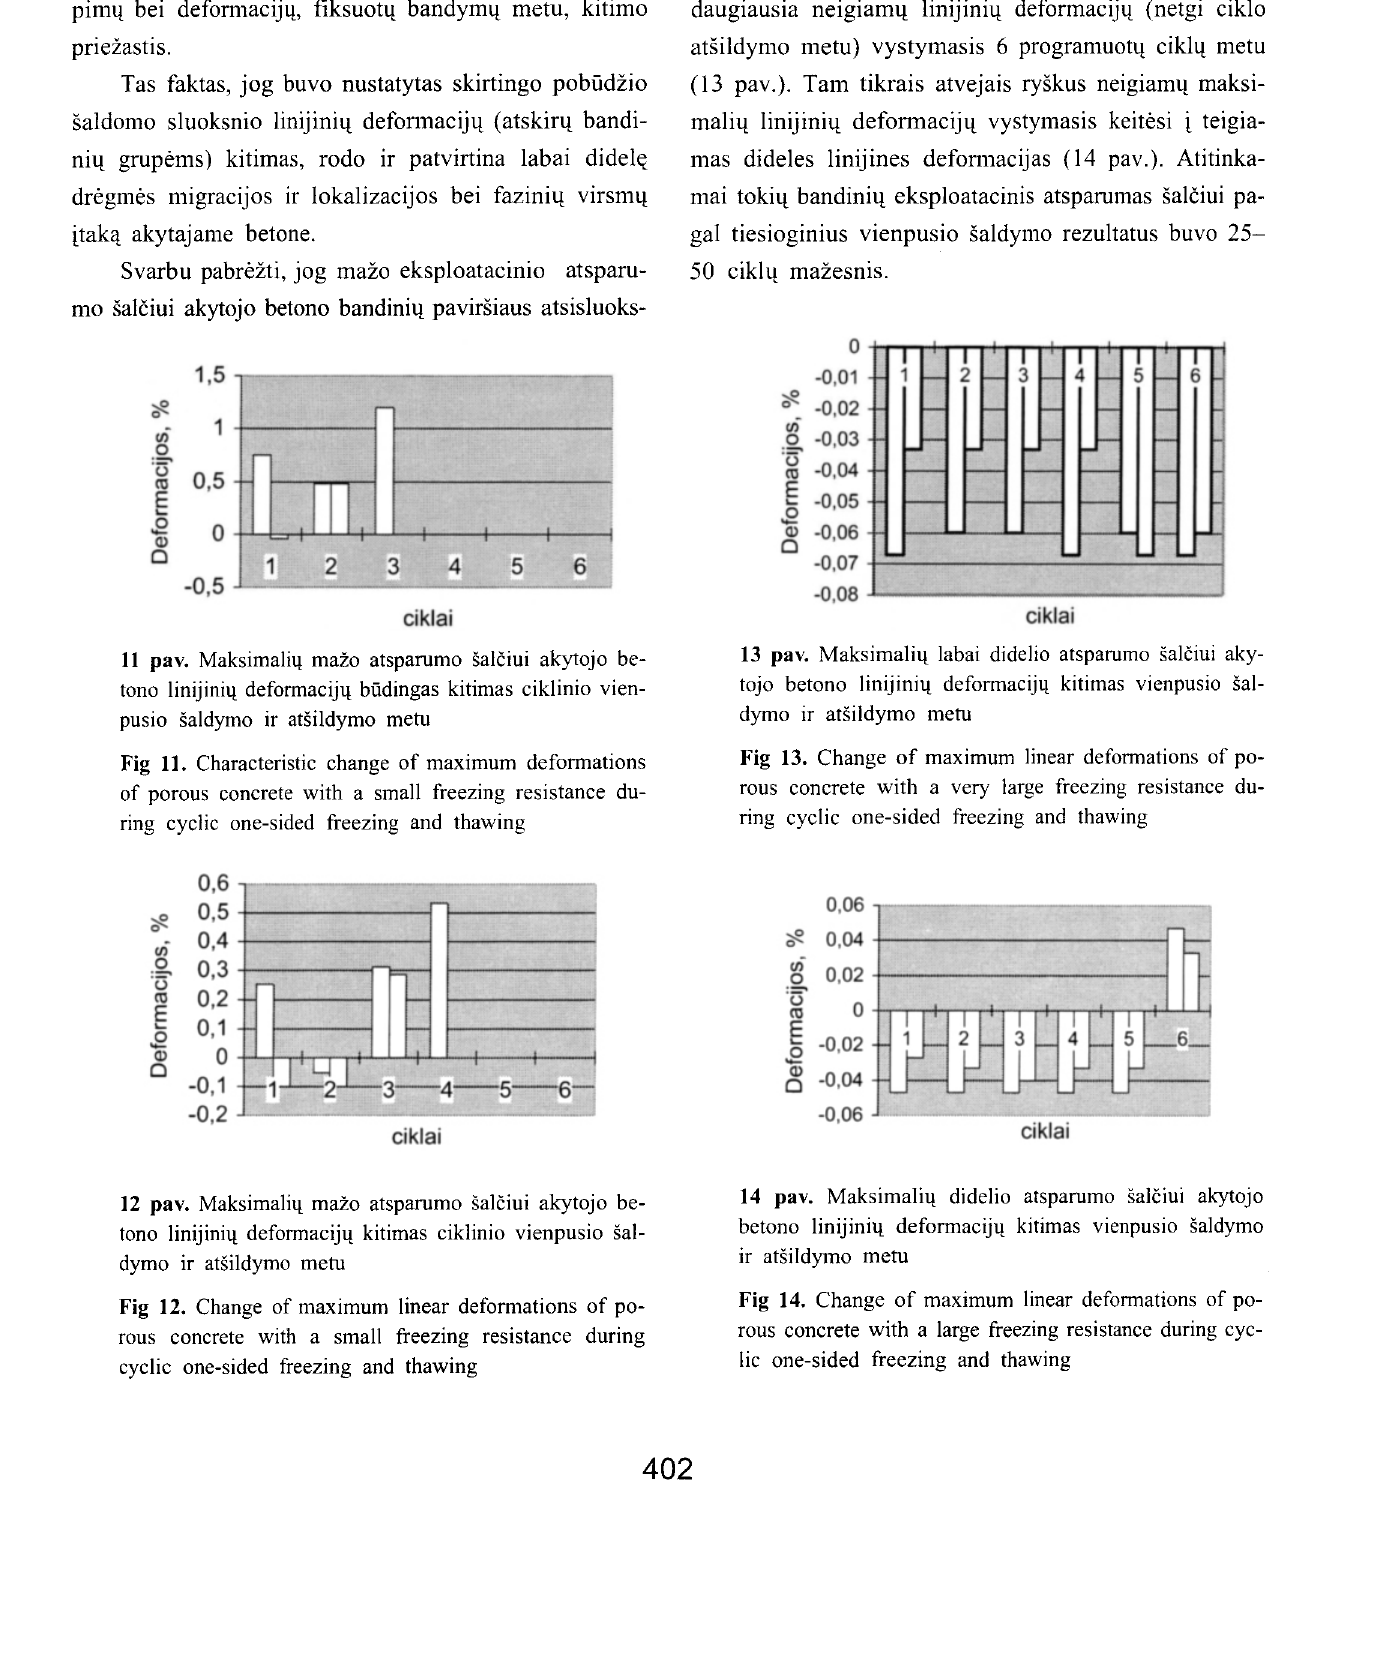
Fig 12. Change of maximum linear deformations of po rous concrete with a small freezing resistance during cyclic one-sided freezing and thawing